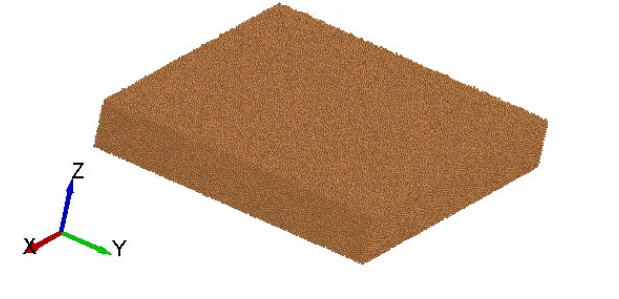
Figure 9. DEM simulation of soil shear test. In order to remove the bulldozing resistance caused by soil accumulation, the cal- culation domain of the particles was adjusted. The soil shear test was performed based on adjusting the particle calculation domain. The virtual soil bin and simulation of the shear process between the clay and track segment with the EDEM software are shown in Figure 10. In the virtual shear simulation, there was no soil accumulation in front of the track segment.